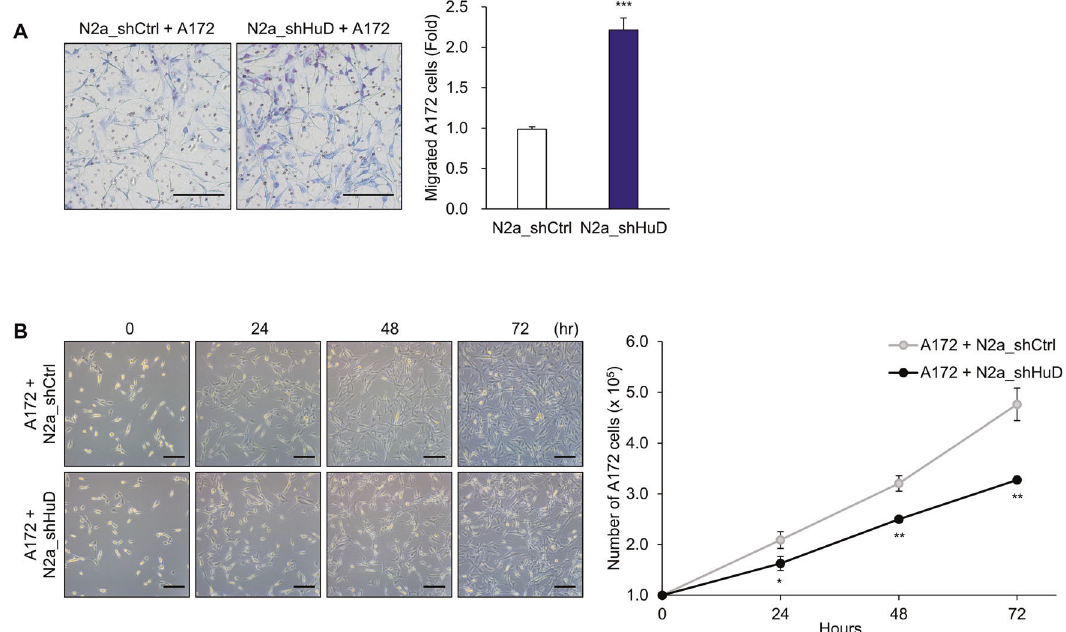
Fig. 6 Alterations in migration and growth of A172 cells co-cultured with N2a_shHuD cells. A A172 cells (upper chamber) and N2a cells (lower chambers) were co-cultured for 48 h and migration of A172 cells were determined by staining of migrated cells on the transwell membrane. B A172 cells (lower chamber) and N2a cells (upper chambers) were co-cultured and the number of A172 cells was analyzed by cell counting at each time point. Images are representative, and data indicate the mean ± SEM derived from three independent experiments. Scale bar, 200 μ m. The statistical signi fi cance of the data was analyzed via Student ’ s t -test; * p < 0.05; ** p < 0.01; *** p <